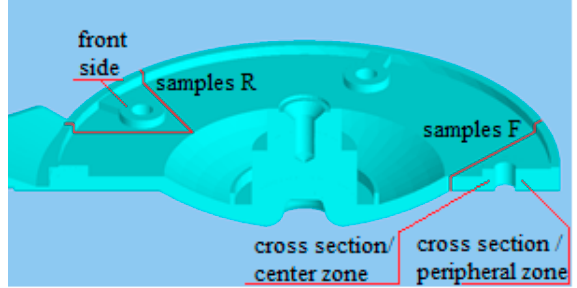
Figure 3. Evaluated locations of eutectic structures.